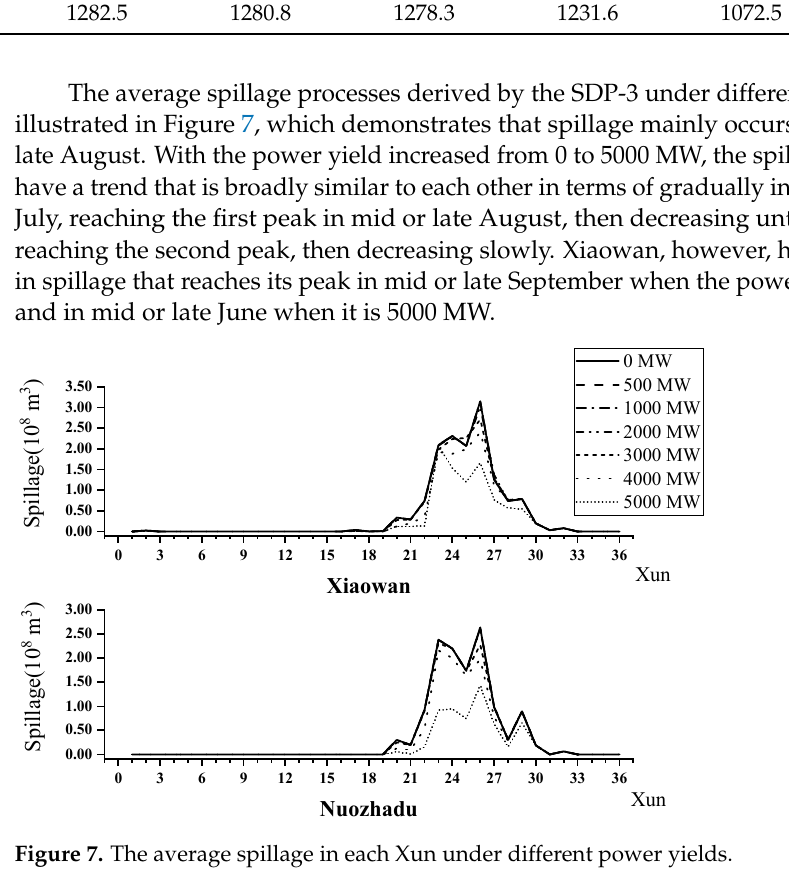
Table 4. Annual energy and spillage under different power yields by the SDP-3.